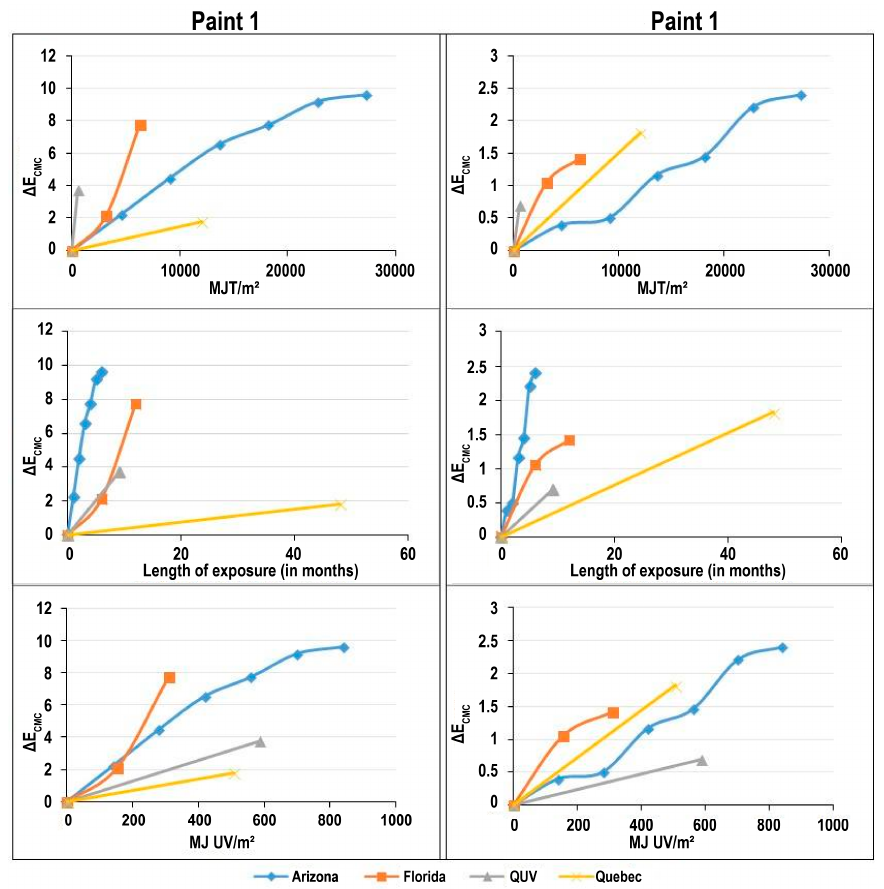
Figure 2. Δ E CMC parameters for Paint 1 (left) and Paint 2 (right). Figure 2. ∆ E CMC parameters for Paint 1 (left) and Paint 2